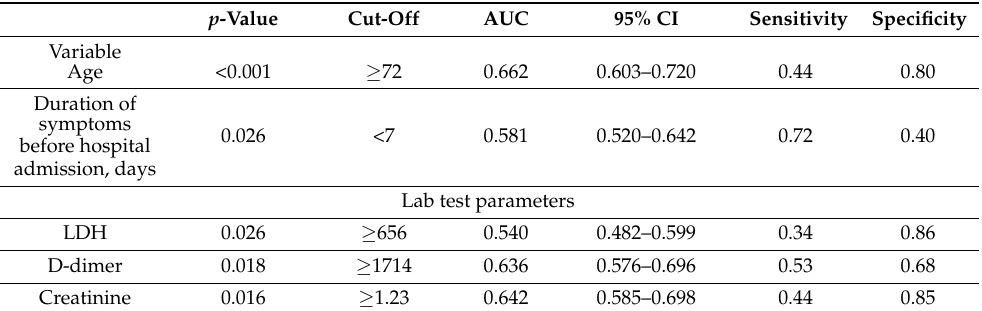
Table 2. AUC, cut-off, sensitivity and specificity for predicting mortality in a patient with COVID-19 according to parameters assessed on admission with p < 0.05 (determined by Youden Index).